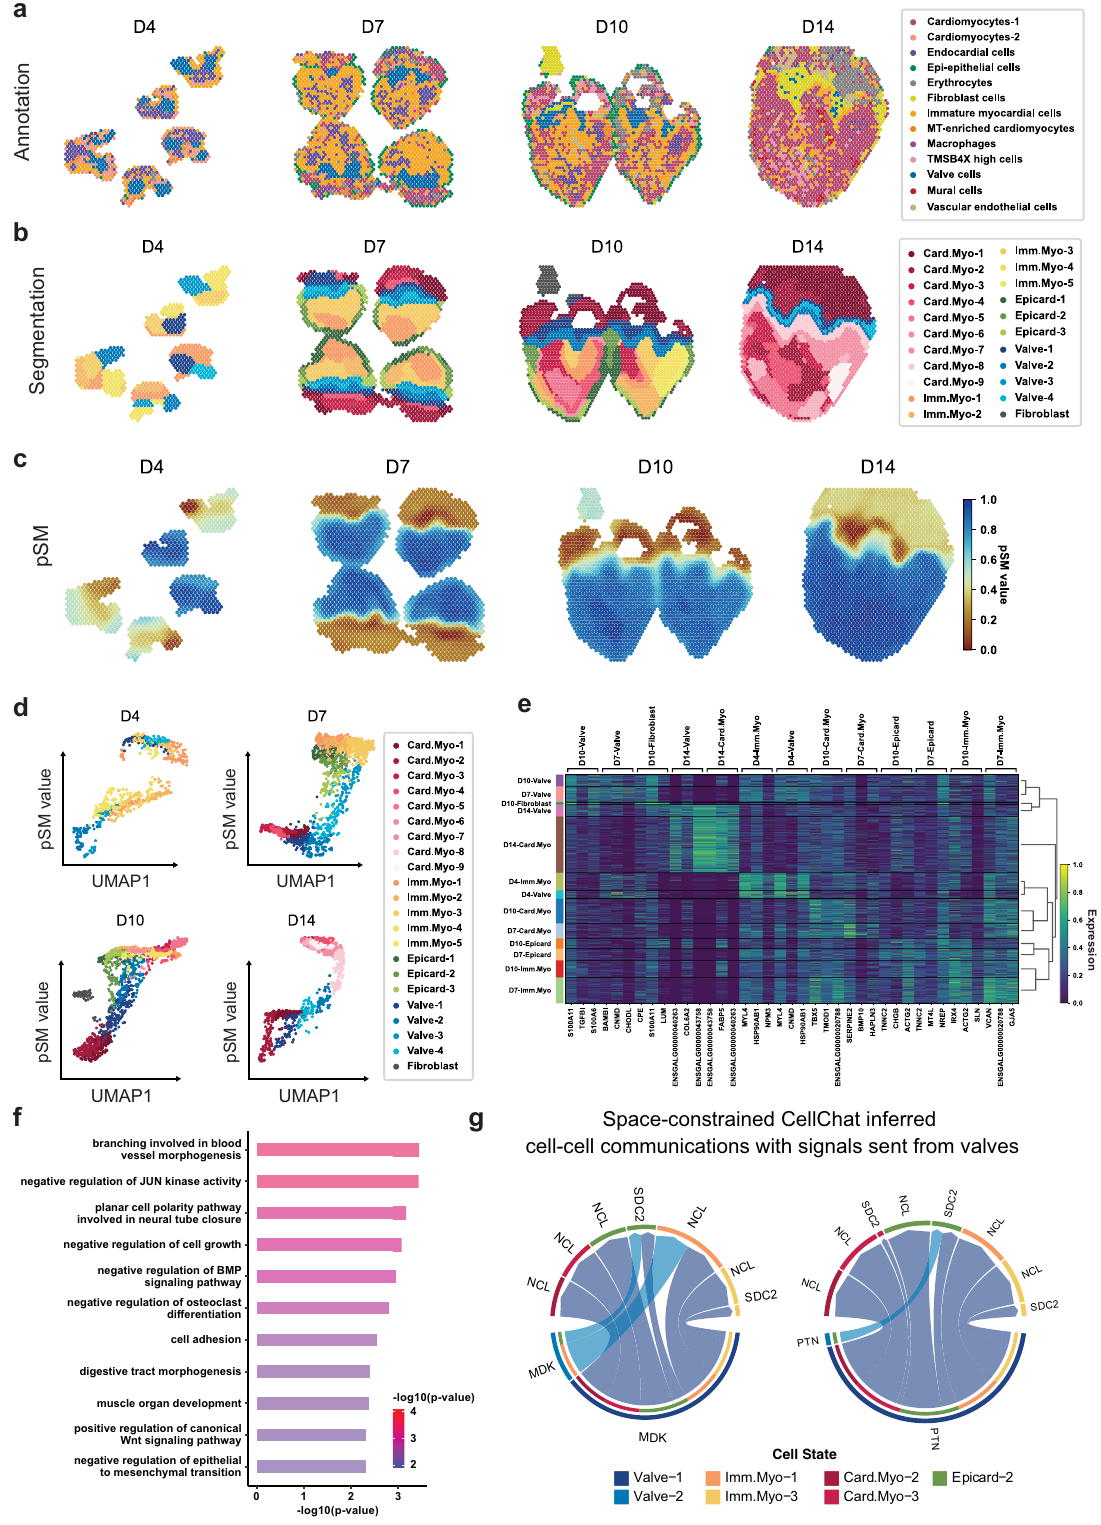
Immune:B/plasma, and Cancer 1 respectively from the original study. However, we also identi fi ed three tumor-immune interface regions, labeled as Tu.Imm.Itfc-1/2/3, which were labeled as mix- tures of other cell types in the original study.